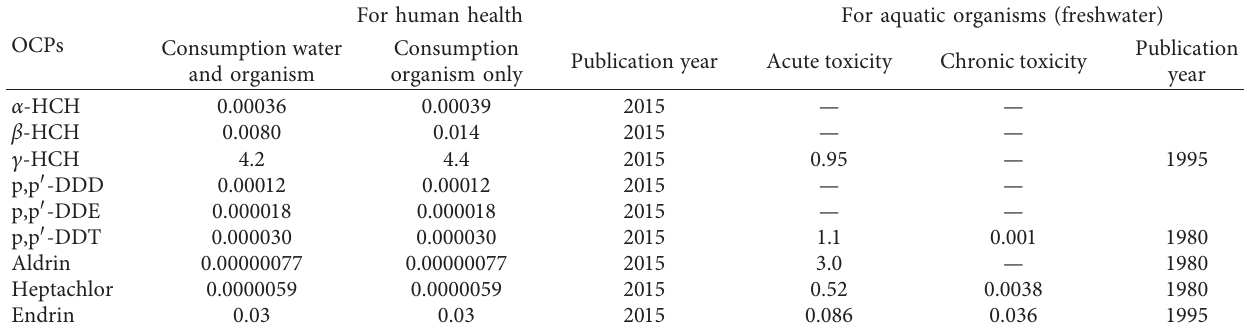
Table 4: National recommended water quality standards for OCPs ( μ g · L − 1